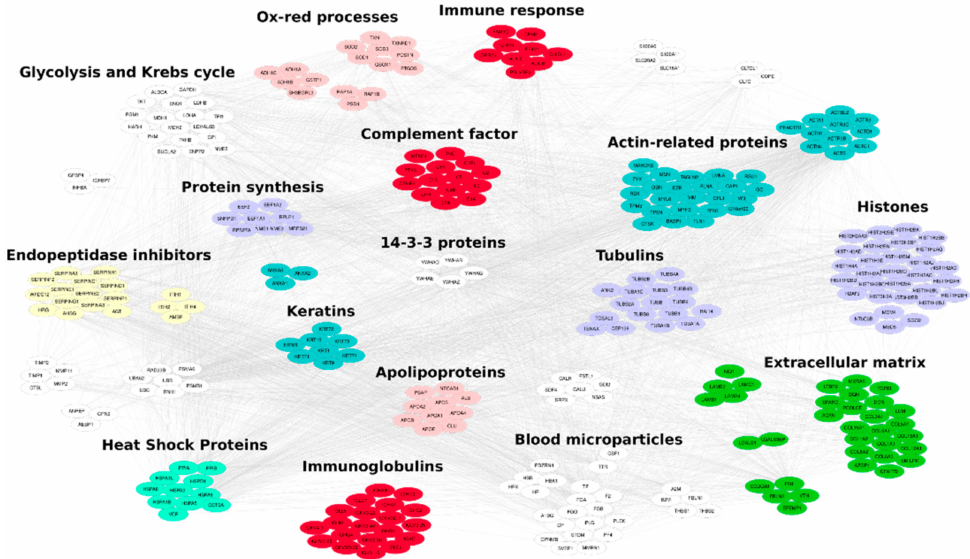
Figure 7. Protein-protein interaction (PPI) network reconstructed by considering the proteins identified by analyzing the lyo-secretome obtained by adipose-derived mesenchymal stem cells. The network counts 314 proteins and 3836 interactions retrieved from the major PPI repositories. Functional modules were selected by using Bingo 2.44 Cytoscape plugin. Red nodes: Immune system, Pink nodes: Oxidation-reduction processes, Violet nodes: Genetic Information Processing, Green nodes: Extracellular matrix, Light green nodes: Heat Shock Proteins, Yellow nodes: Endopeptidase inhibitors, Blue nodes: Cytoskeleton, White nodes: